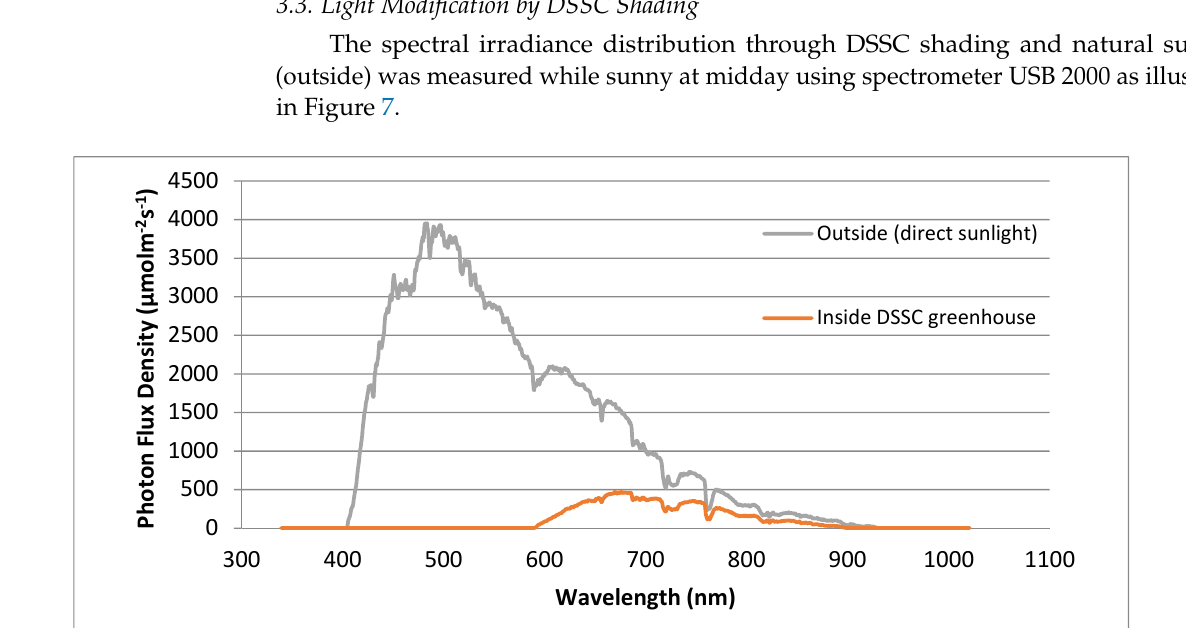
Figure 7. Spectral distribution outside and under integrated DSSC shading greenhouse. The results revealed that red semi-transparent DSSC has a broad irradiance from the red region (600 nm) and above, and started to decline gradually in the far-red region from 826 nm. In addition, the red semi-transparent DSSC absorbs UV at the rate of 300–400 nm, blue region (400–500 nm), and green-yellow region (500–600 nm). In addition, the spectral irradiance of natural sunlight (outside) has a broad irradiance from UV up to the far-red region. However, the spectrometer used in this study is less sensitive to the UV region and the value was very small. The uniqueness of the semi-transparent DSSC is spectral manipulation (due to its variation of color as determined by the dye) and the scattering of transmitted light. Its ability to use diffuse light efficiently makes DSSC perform optimally despite low light settings, resulting in DSSC as a fantastic choice for greenhouse and windows (indoor purposes) [24]. Inada [59] states that the photosynthetic spectrum of energy hit the highest point in the red color range while only little for the blue color